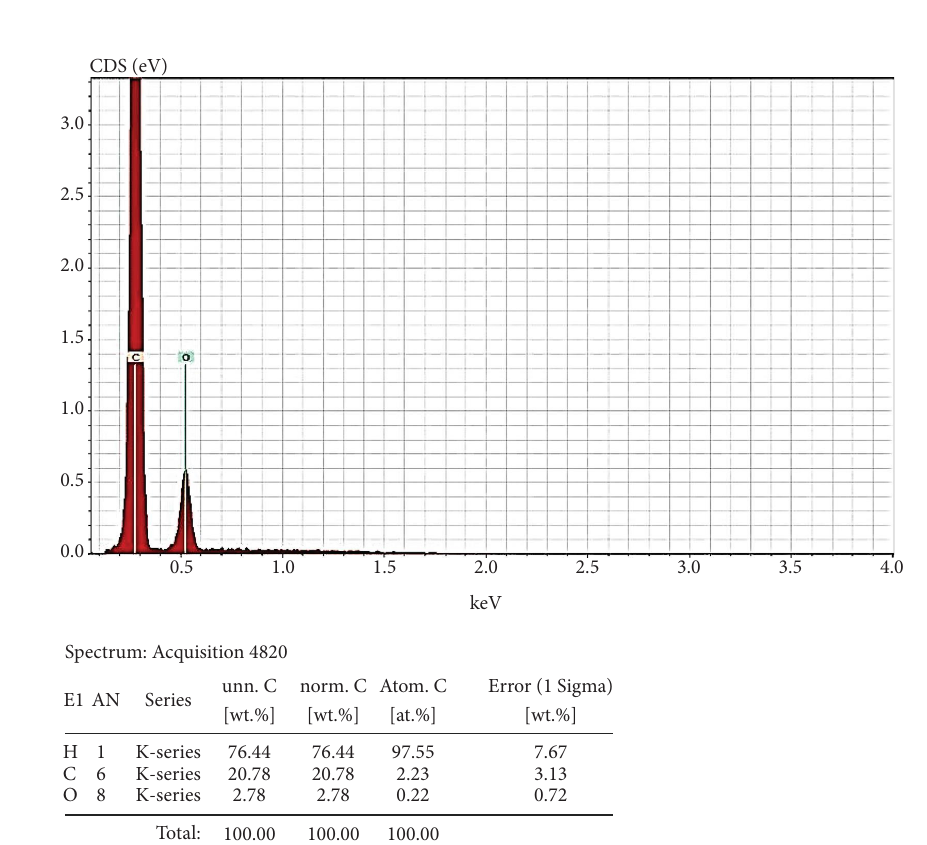
Figure 2: EDX image for the PEEK.